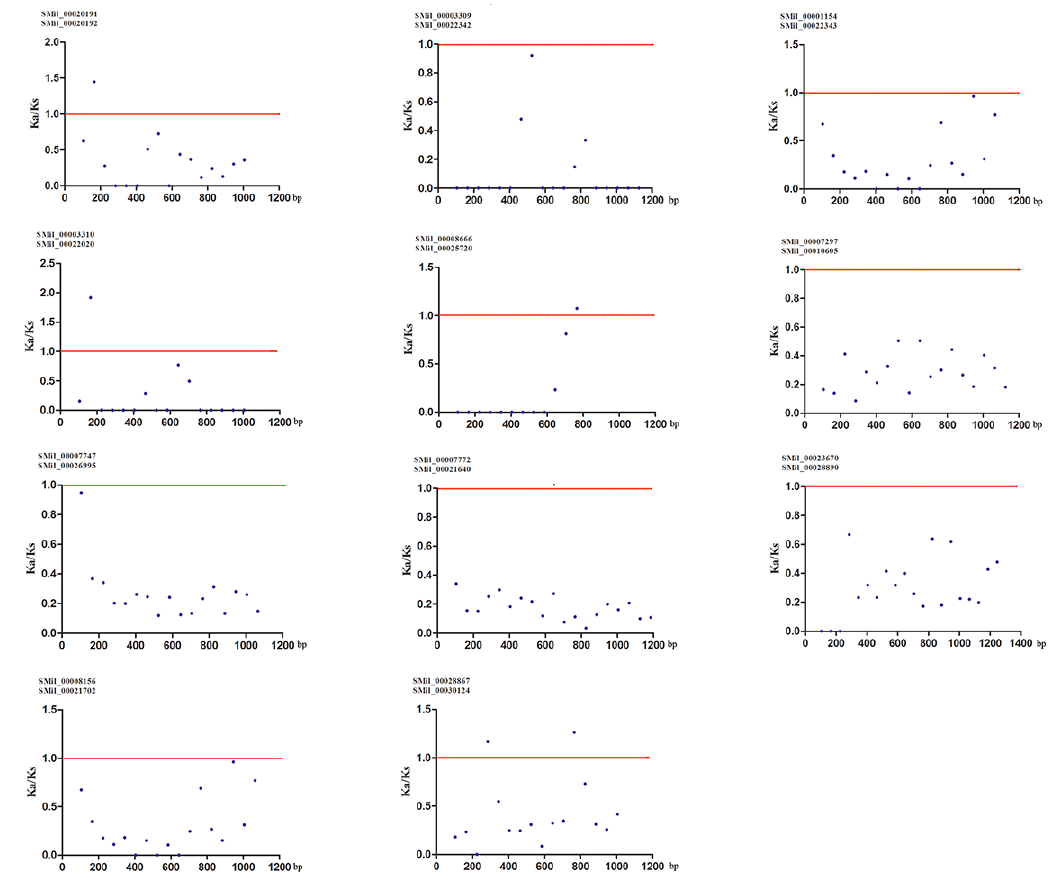
Figure 4. Ka (non-synonymous)/Ks (synonymous) ratios for 11 SmSABATH paralogous pairs of proteins with a sliding window of 20 amino acids. The plot shows the Ka/Ks ratios at various positions for the coding region of SmSABATH genes.